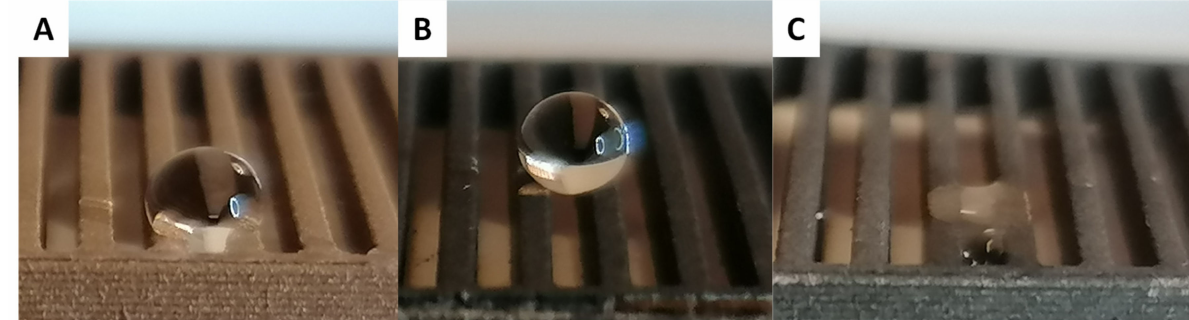
Figure 10. Example of water drop deposed on GVB surfaces. ( A ) Cu, ( B ) C 18 and ( C ) Gly. Surprisingly, Cu(OH) 2 surfaces present globally higher hydrophobic features com- pared with the Cu surfaces of the same design (PVB Cu(OH) 2 : θ = 146.2 ◦ ± 2.8, LMG Cu(OH) 2 : θ = 139.3 ◦ ± 1.3 and NMG Cu(OH) 2 : θ = 144.7 ◦ ± 1.0). Only the GVB Cu(OH) 2 surface presents a lower contact angle value, but still remains strongly hydrophobic with θ = 128.9 ◦ ± 1.2. For surfaces functionalized with linear carboxylic acids, an increase in hydrophobicity is observed after functionalization. No significant differences are observed between the different linear carboxylic acids employed, and globally all carboxylic acid functionalization display strong hydrophobic properties. Only surfaces functionalized with acetic acid were “less” hydrophobic than the others, having apparent contact angles ( θ ) be- tween 145 ◦ and 155 ◦ . Respectively, the contact angles are θ = 150.1 ◦ ± 0.4, θ = 154.4 ◦ ± 1.1, θ = 144.0 ◦ ± 1.2 and θ = 149.6 ◦ ± 2.0 for PVB C 2 , GVB C 2 , LMG C 2 and NMG C 2 surfaces.